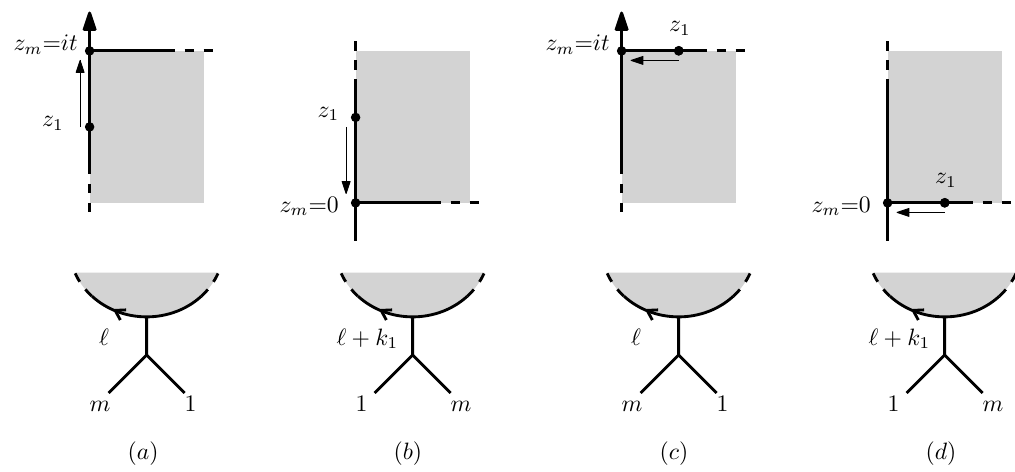
Figure 8 . Four graph degenerations near the worldsheet edges, ( a - d ) . Top: worldsheet (gray) with puncture z 1 approaching z m from various boundaries. Bottom: corresponding graphs with resulting (1 m ) tree pinching